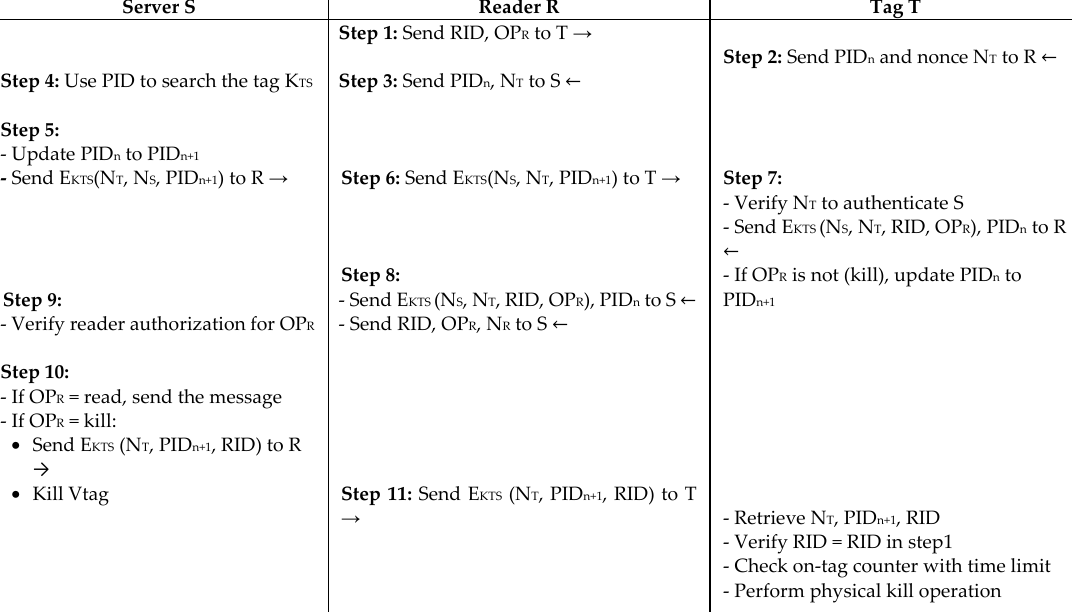
Figure 2. Session-Based Authentication Protocol (SB-A) by Wang and Sarma.